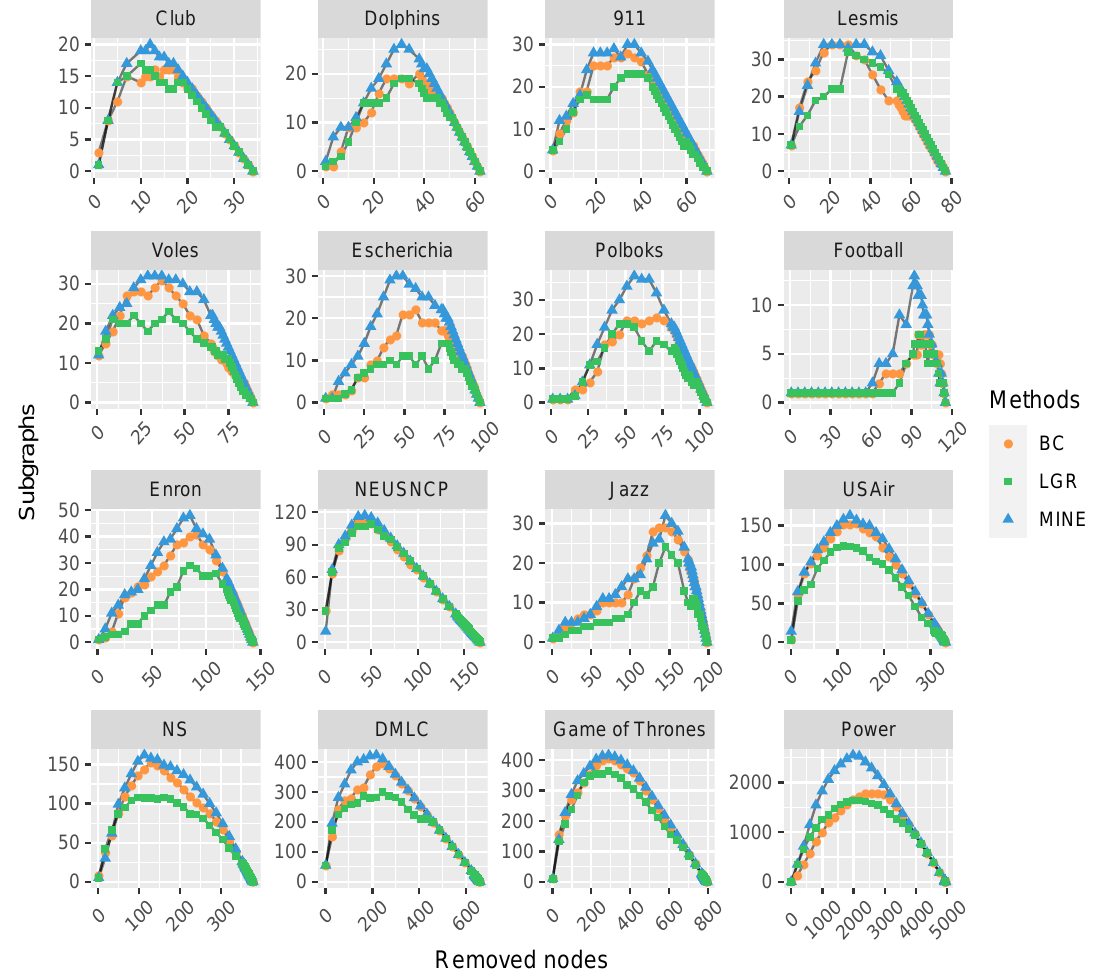
Figure 2. The comparison of varying subgraphs with the removal of the most influential nodes repeatedly with each centrality method on 16 monolayer networks. The proposed MINE algorithm (marked with blue triangles) shows superiority to the BC and LGR methods by obtaining more subgraphs in the removal